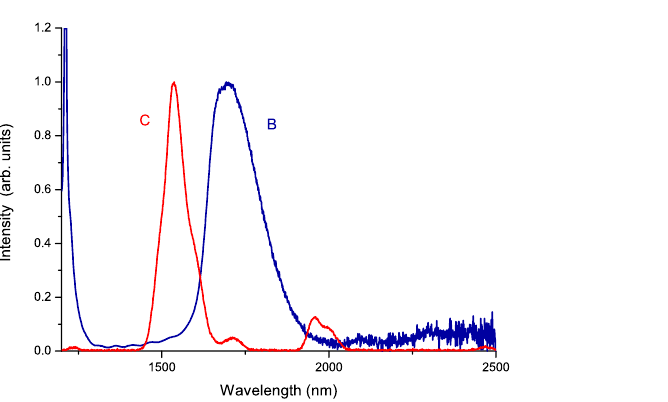
Figure 7. Lifetimes of the 1537-nm luminescence peaks in samples (A) Er 3 + (8%)Tm 3 + (0.5%):telluride glass, (C) Er 3 + (0.5%):telluride glass, and (D) Er 3 + (8.0%):telluride glass when excited by 380 nm light for the 4 I 3 + ions. → 4 G 15/2 11/2 absorption of Er